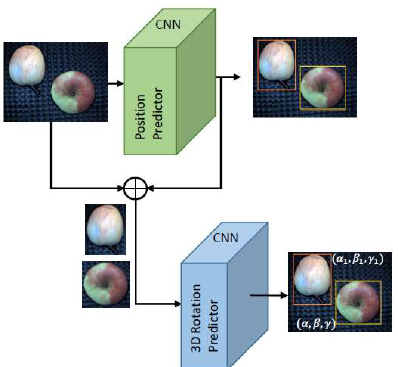
Figure 3. Pipeline of the proposed system using cascaded convolutional neural networks (CNNs).